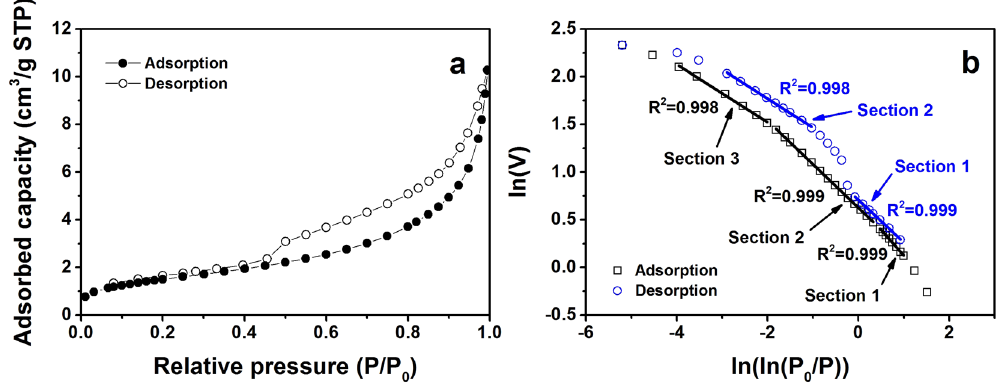
Figure 2. Typical low-pressure N 2 sorption (San Juan coal). ( a ) Low-pressure N 2 adsorption-desorption isotherms; ( b ) ln V -ln[ln( P 0 / P )] plot of N 2 isotherms for fractal